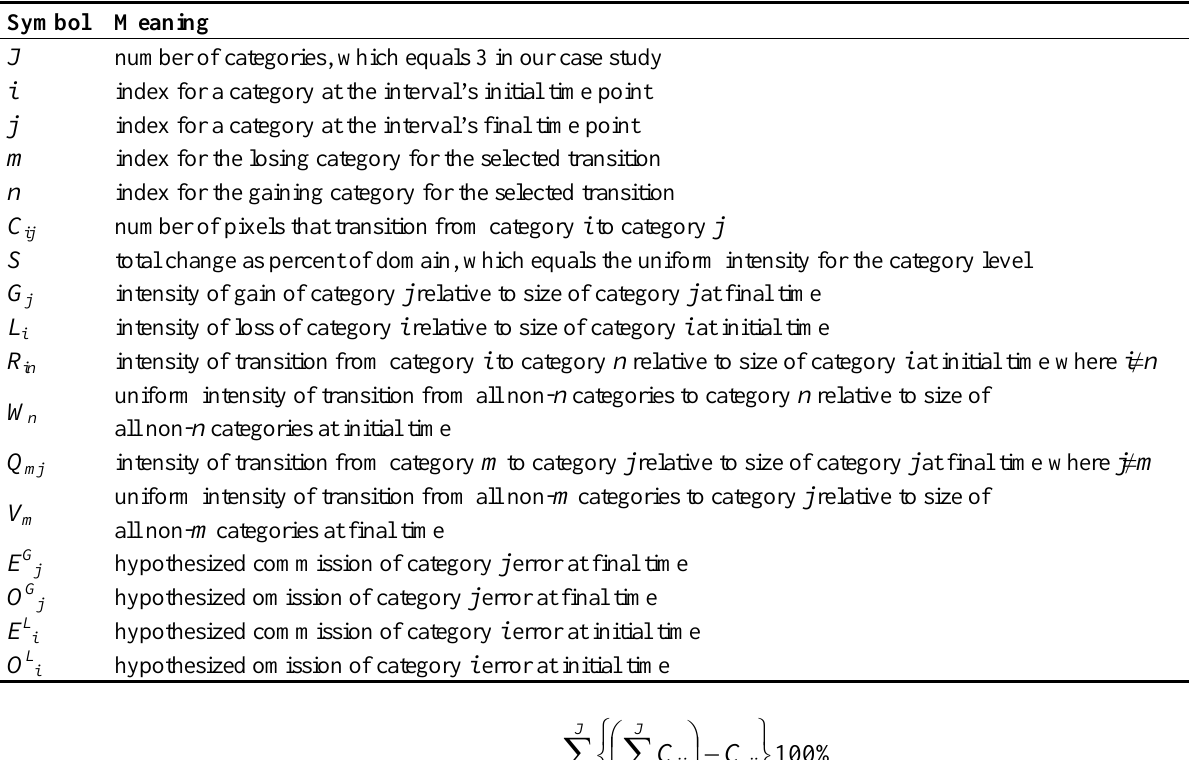
Table 2. Mathematical notation for Intensity